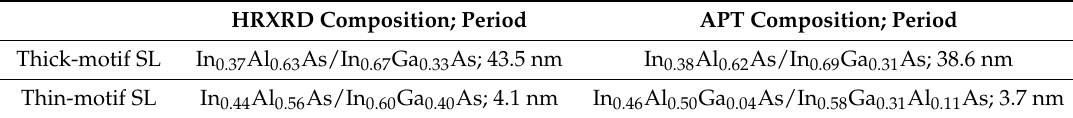
Figure 3. Atom maps for the obtained atom probe tomography (APT) for ( a ) thick-motif SL ( b ) thin-motif SL. Table 2. SL layer compositions and SL periods as obtained by HRXRD simulations and APT reconstructions.